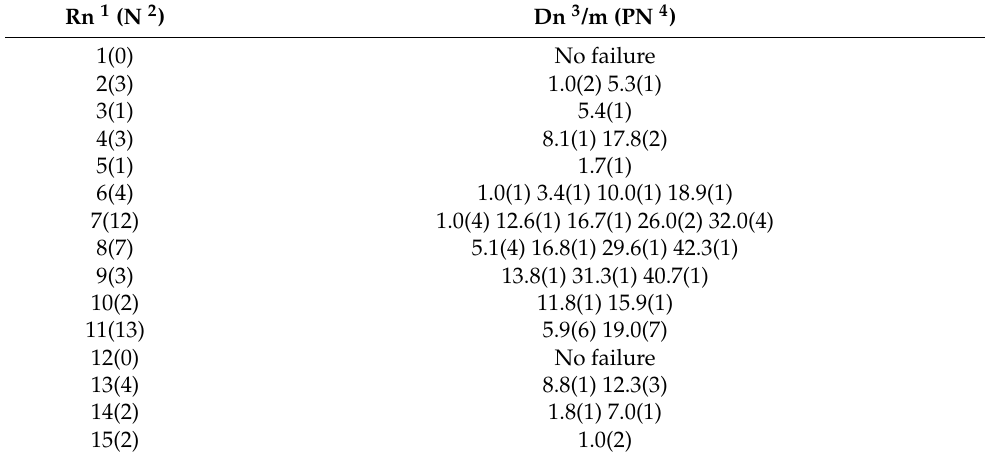
Table 3. Failure information of Test_2.